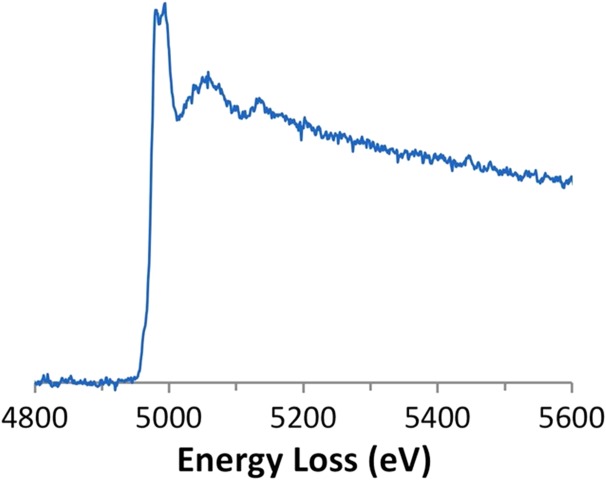
A background subtracted, deconvolved Ti-K edge from amorphous TiO2 (t/λ = 0.70, 1000 s acquisition).